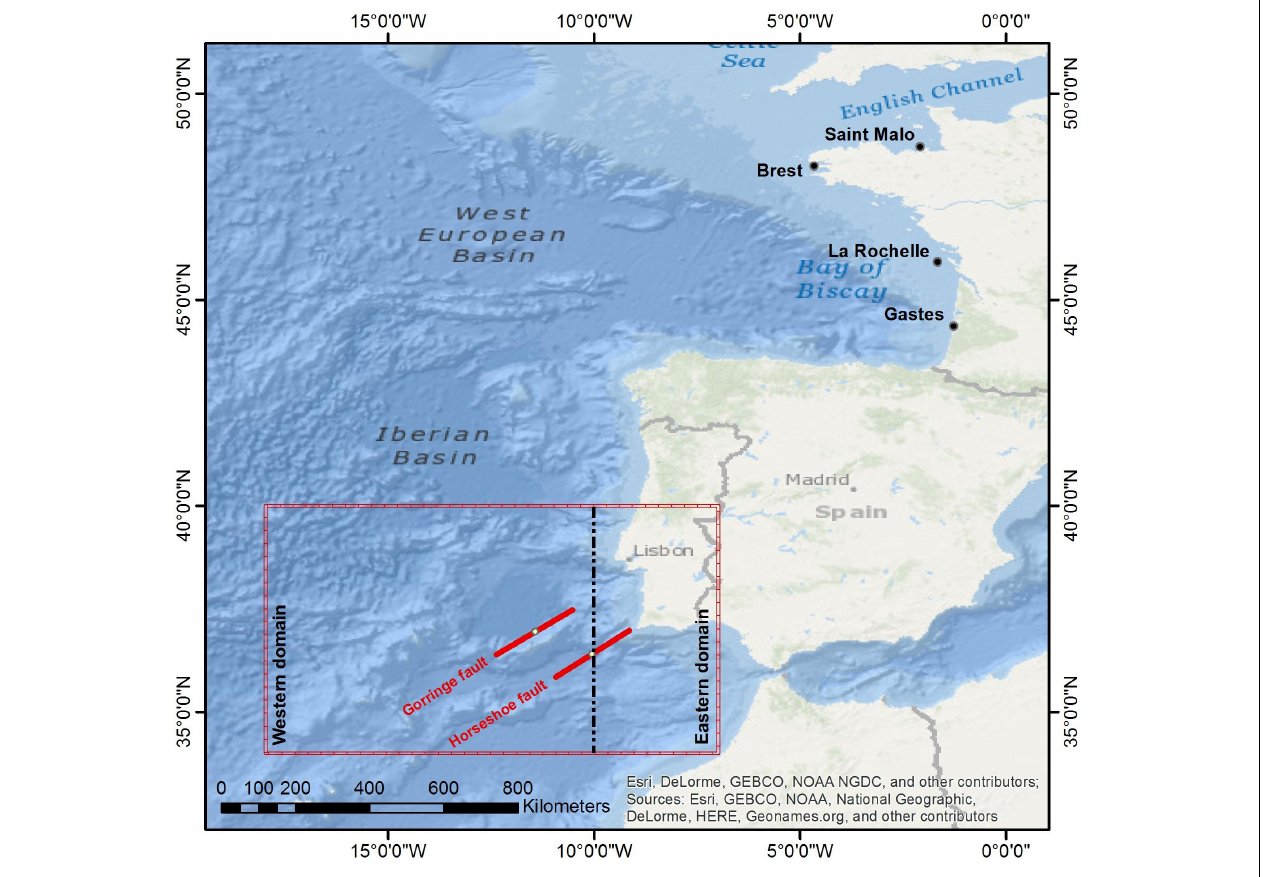
FIGURE 3 | Bathymetry covering the computational domain. Red cross hatching area shows location of tsunamigenic sources used for meta-models construction. The points represent the gauge locations selected for tsunami database construction along the French Atlantic Coast. Gorringe fault and Horseshoe fault are special structures at the boundary between the Eastern domain (on the right) and the Western domain (on the